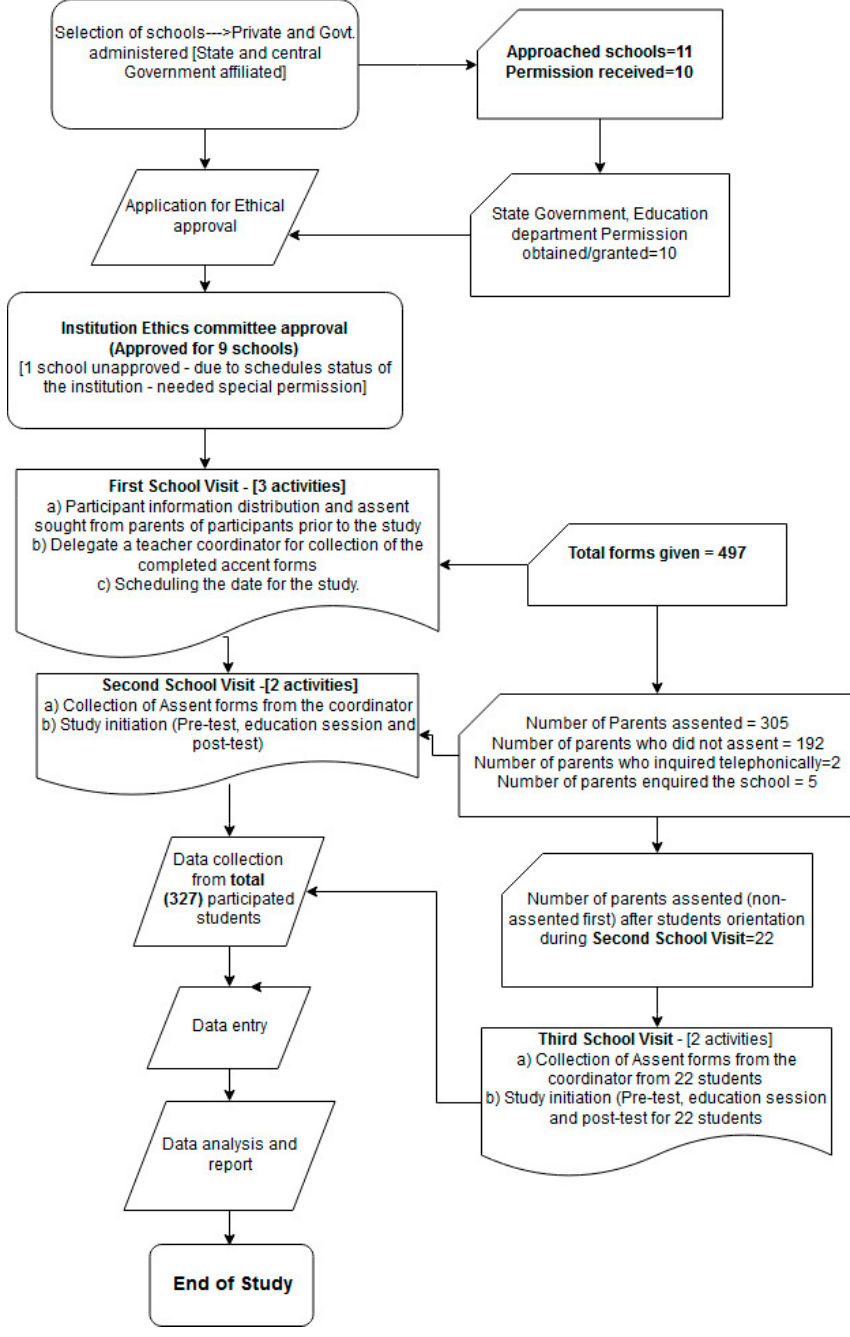
Figure 1. Overview of study methodology.